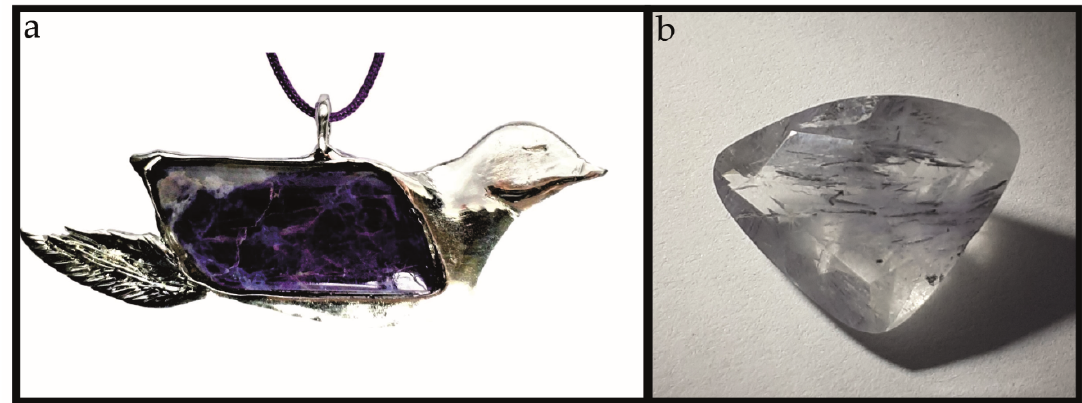
Figure 2. Pendant of violane, 3.5 cm × 2.5 cm, photo by “Lutezia Gioielli, Stradella, Pavia, Italy” ( a ) and quartz trillion cut containing violet inclusions of violane, 2.5 ct, photo by F. Caucia ( b ).